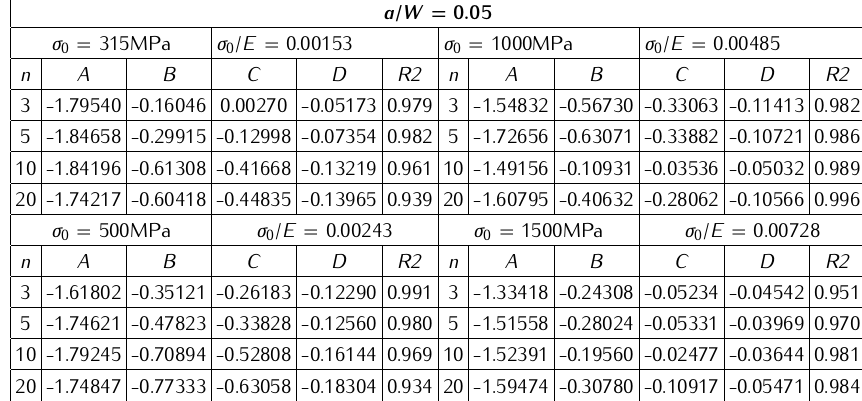
Table 4. The coefficients of equation (13) for CC(T) specimen with the crack length a / W =0.05.